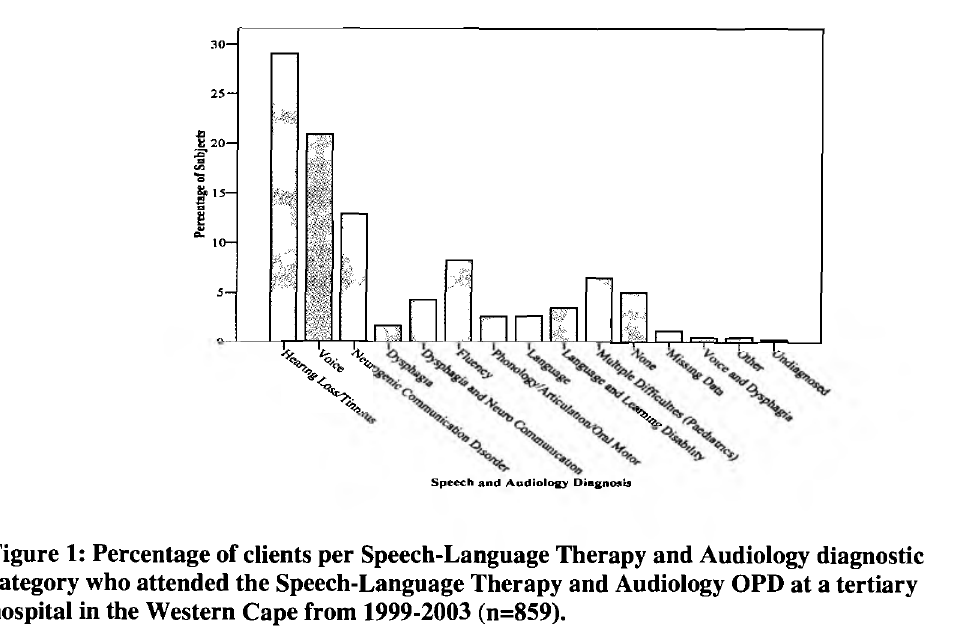
Figure 1: Percentage of clients per Speech-Language Therapy and Audiology diagnostic category who attended the Speech-Language Therapy and Audiology OPD at a tertiary hospital in the Western Cape from 1999-2003 (n=859).